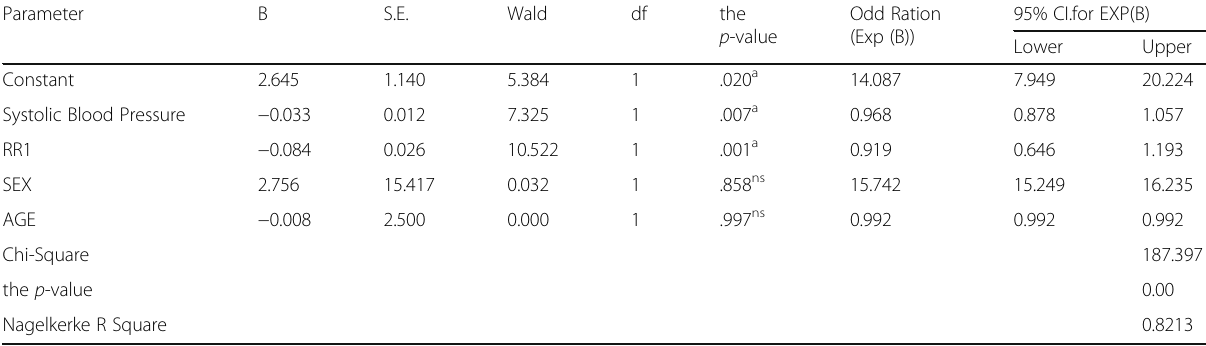
Table 9 Summary of logistic regression analysis (Y = 0 for DIV < 2 and 1 for > 2) Parameter